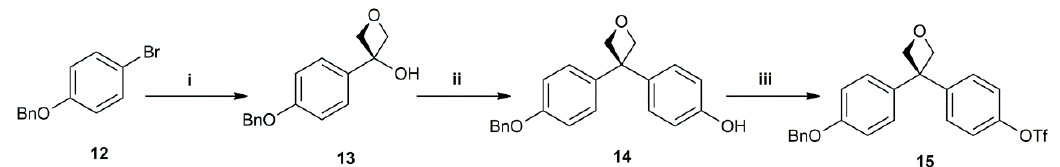
Table 1. N -arylamine oxetanes obtained via Buchwald–Hartwig Reaction.